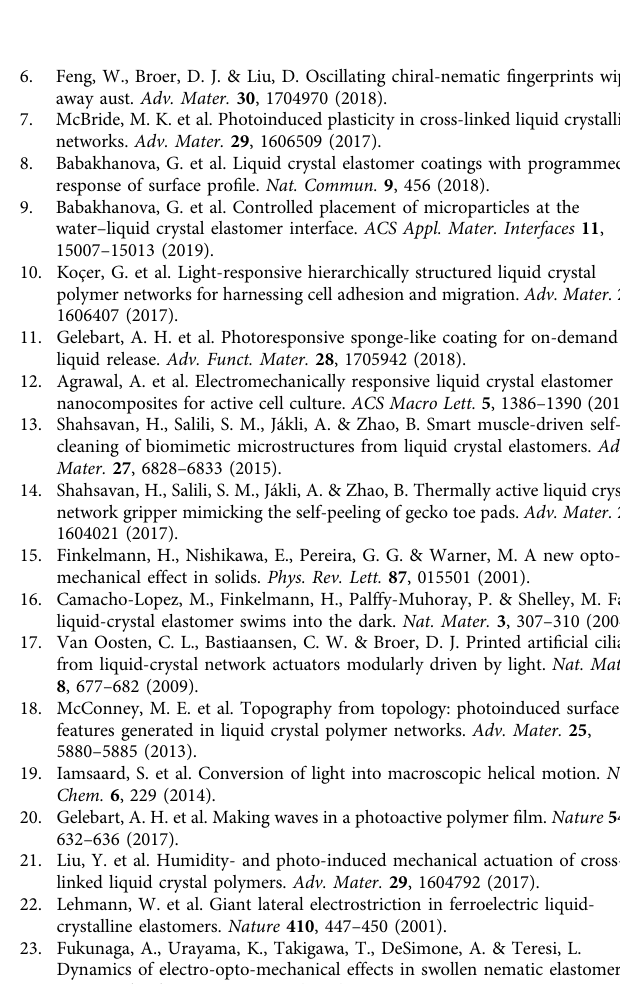
Fig. 7 Chemical structures of the monomers used in the LCN